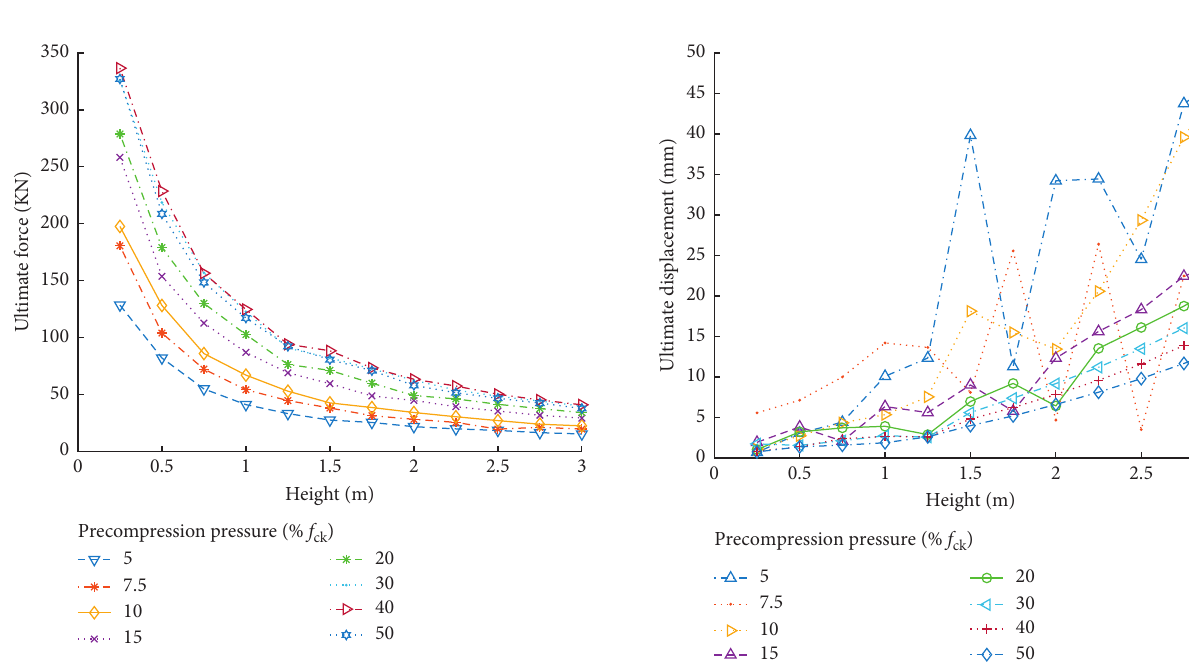
Figure 7: Ultimate displacement vs height plot for different pre- compression ratios.